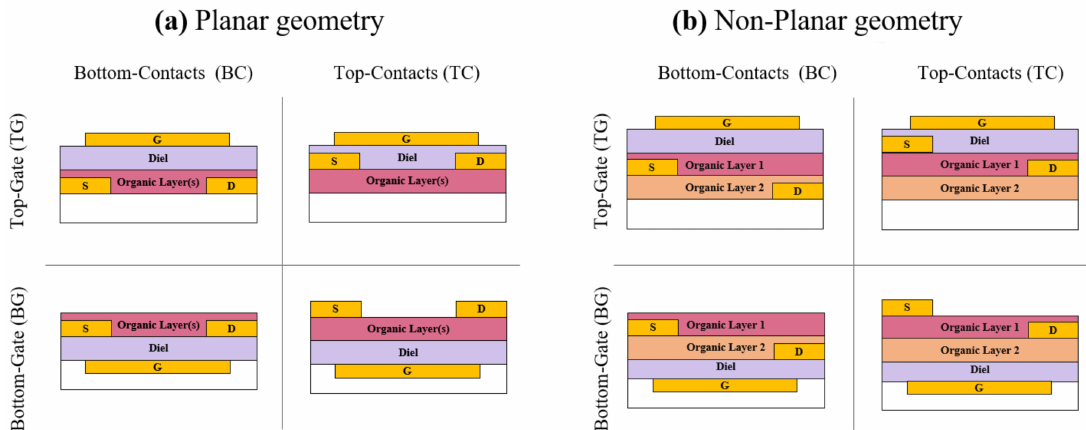
Figure 4. OLET electrodes configuration. Organic light emitting transistor electrodes configurations in case of ( a ) planar and ( b ) non-planar geometry of source and drain. In case of non-planar electrodes and multi-layers stack, source and drain can be located at different level within the device architecture (few representative examples